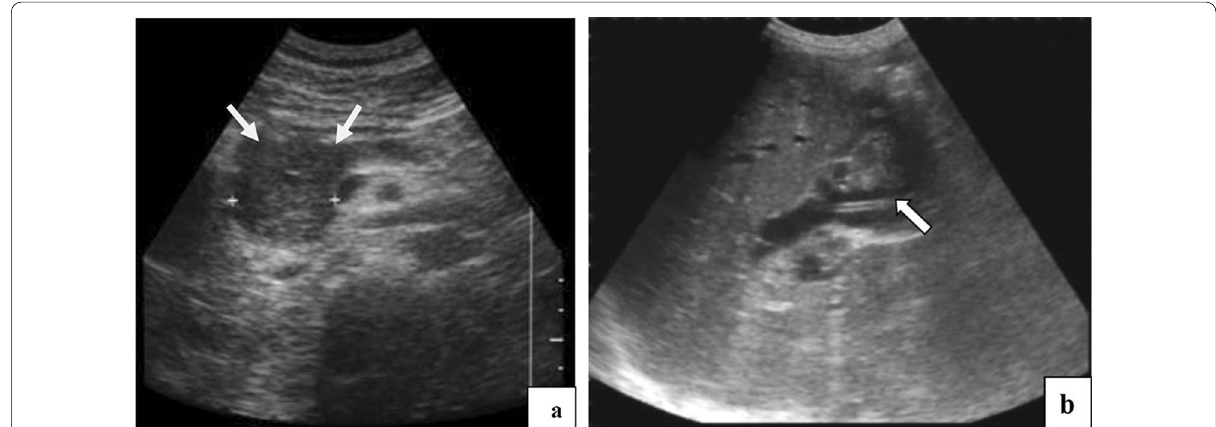
Fig. 4 A 65‑year‑old male patient with malignant biliary obstruction due to pancreatic neoplasm. a Ultrasound shows hypoechoic pancreatic head mass (arrows). b Ultrasound shows CBD stent placement (arrow) by ERCP